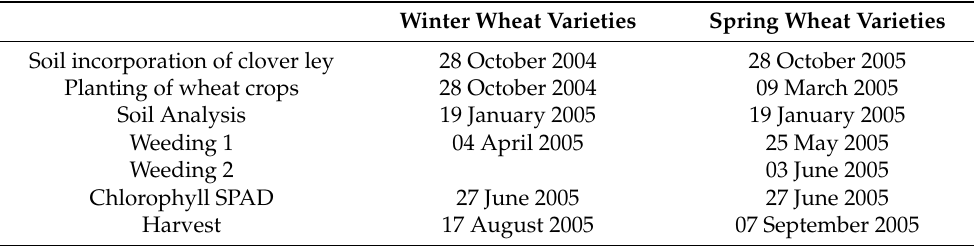
Table 3. Dates of soil incoporation of clover, planting of wheat crops mechanical weed control, assessments and harvest of winter and spring wheat varieties.